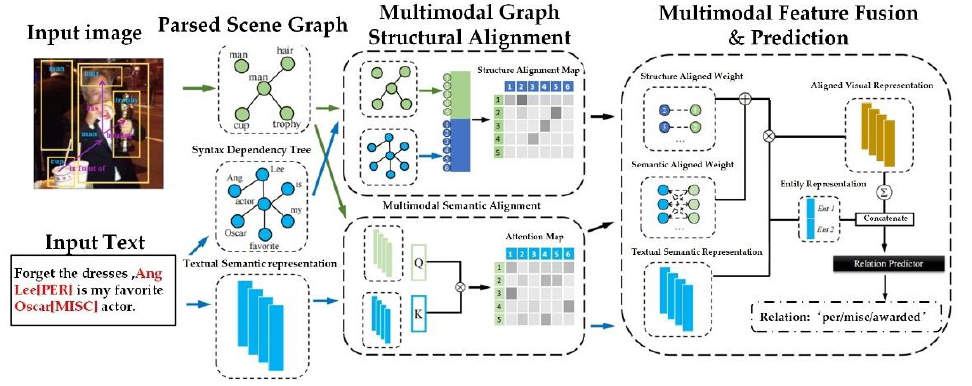
Figure 13. The Overall Framework of the MEGA to learn the correspondence between vision and text [104].